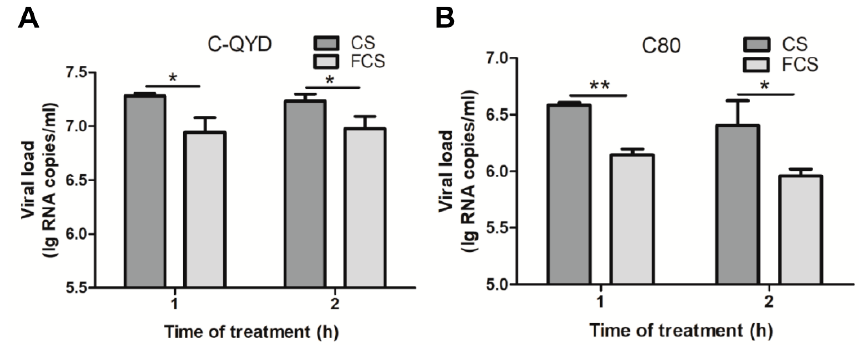
Figure 7. Analysis of e ff ect of FCS on extracellular viral loads. DEF cells inoculated with C-QYD ( A ) or C80 ( B ) were maintained with DMEM and treated with FCS at 37 ◦ C by addition of FCS into the wells at 1 and 2 hpi respectively, and CS was included as a control. The supernatants were collected from three well of 24-well plates, and the viral loads were quantified by RT-qPCR assay. Error bars represent the SD ( n = 3); * p < 0.05; ** p < 0.01.